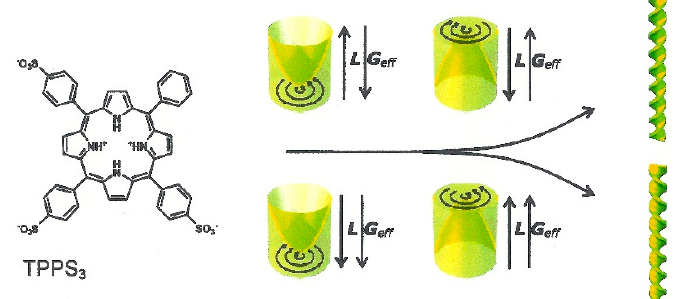
Figure 3. A spinning sample of tris-(4-sulfonatophenyl)phenylporphyrin (TPPS 3 ) in a gravitational field generates aggregates with opposite helicities depending on whether the falsely chiral arrangement of angular momentum and effective gravity vectors L and G eff are parallel or antiparallel. Adapted from [53] with permission from the publisher.